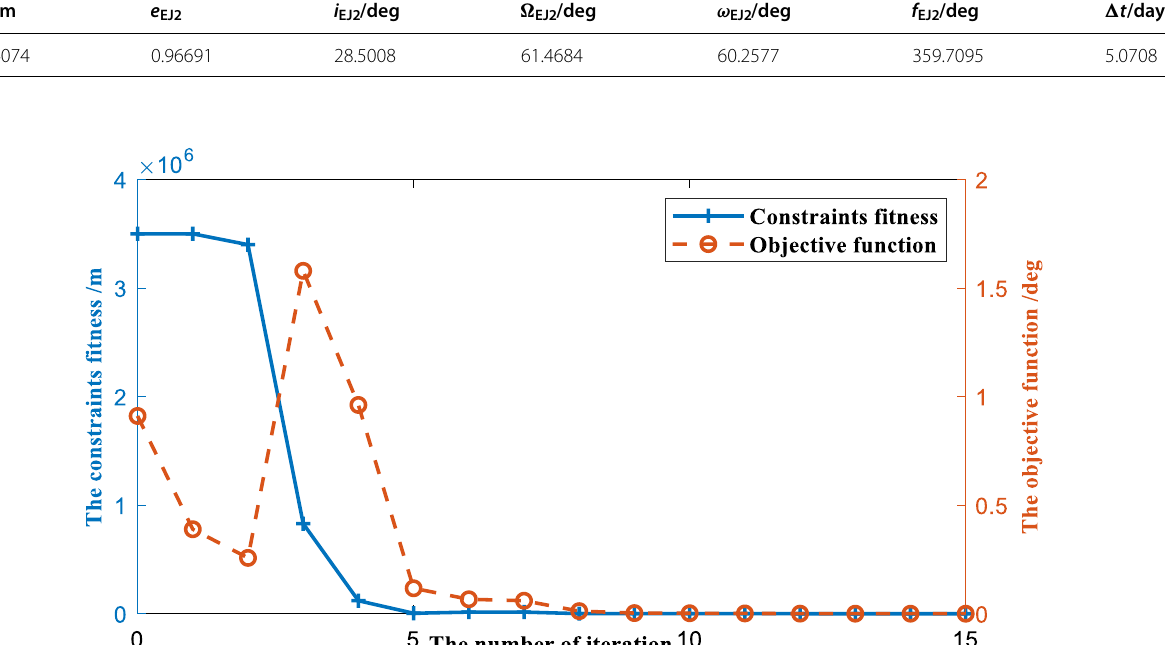
Fig. 7 The iterative process of the optimal objective function and the constraints